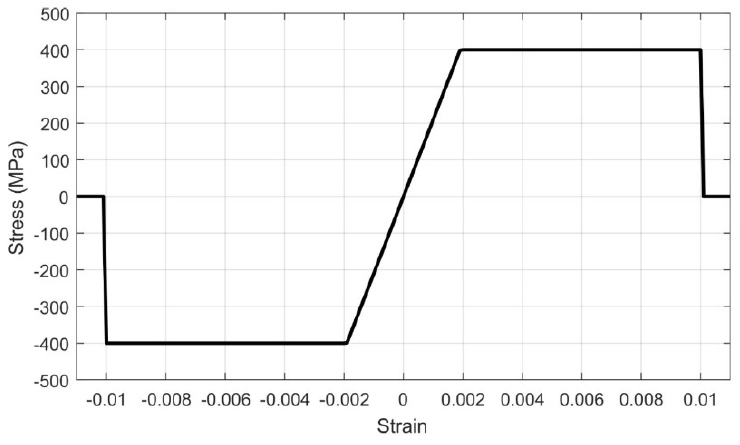
Figure 7. Stress-strain relation for steel with f y = 400MPa.